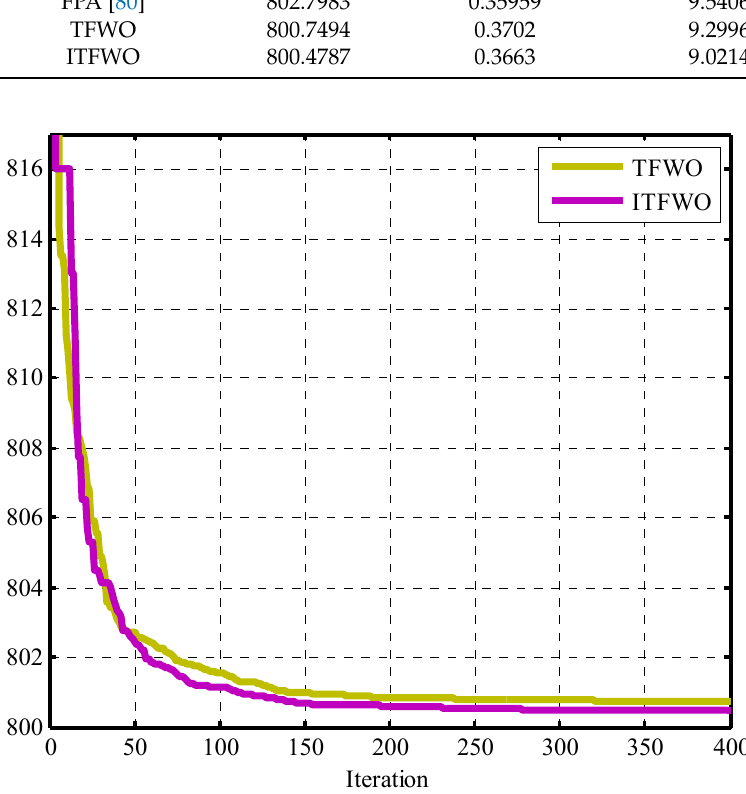
Figure 3. Optimization process for Type 1.